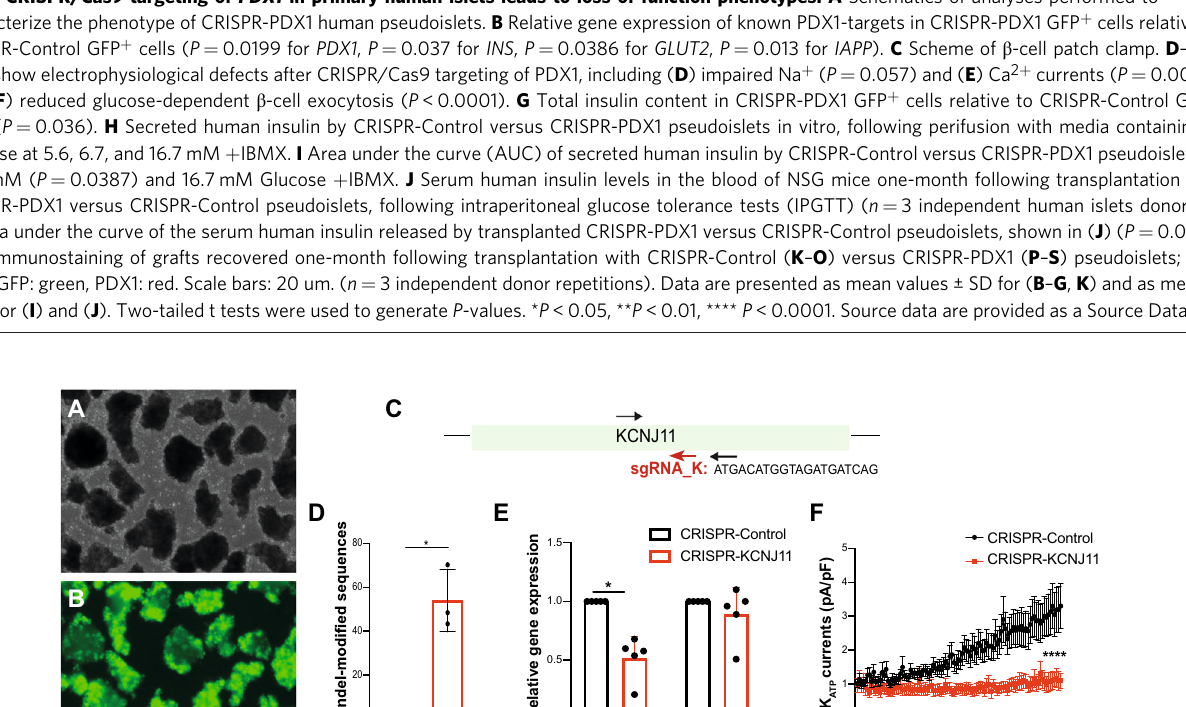
Fig. 3 CRISPR/Cas9 targeting of KCNJ11 protein-coding sequence in primary human islets. A , B Human pseudoislets 5 days post-infection with CRISPR- KCNJ11 lentiviruses ( A ) bright fi eld, ( B ) blue light (488 nm), scale bar: 500 μ m ( n = 3 independent donors). C Schematics of KCNJ11 sequence, showing the sgRNA sequence (sgRNA_K, red). Arrows indicate primers used for PCR. D Percentage of indel-modi fi ed sequences detected by TIDE algorithm ( n = 3 independent donors; P = 0.0225). E qRT-PCR of GFP + cells, CRISPR-KCNJ11 (red), CRISPR-Control (Black) ( n = 5 independent donors; P = 0.0175). F Patch clamping in single β -cells: measurement of K ATP currents in CRISPR-KCNJ11 ( n = 19 cells, 3 replicates) and CRISPR-Control ( n = 25, 3 replicates) ( P < 0.0001). Data are presented as mean values ± SD for ( D – E ) and mean values ± SEM for ( F ). Two-tailed t tests were used to generate P -values. * P < 0.05, **** P < 0.0001. Source data are provided as a Source Data fi